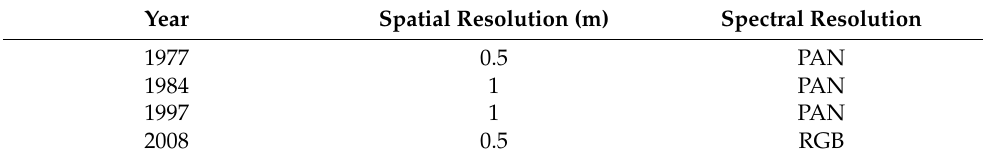
Table 1. Images used in the work. (PAN: panchromatic image; RGB: red-green-blue image).